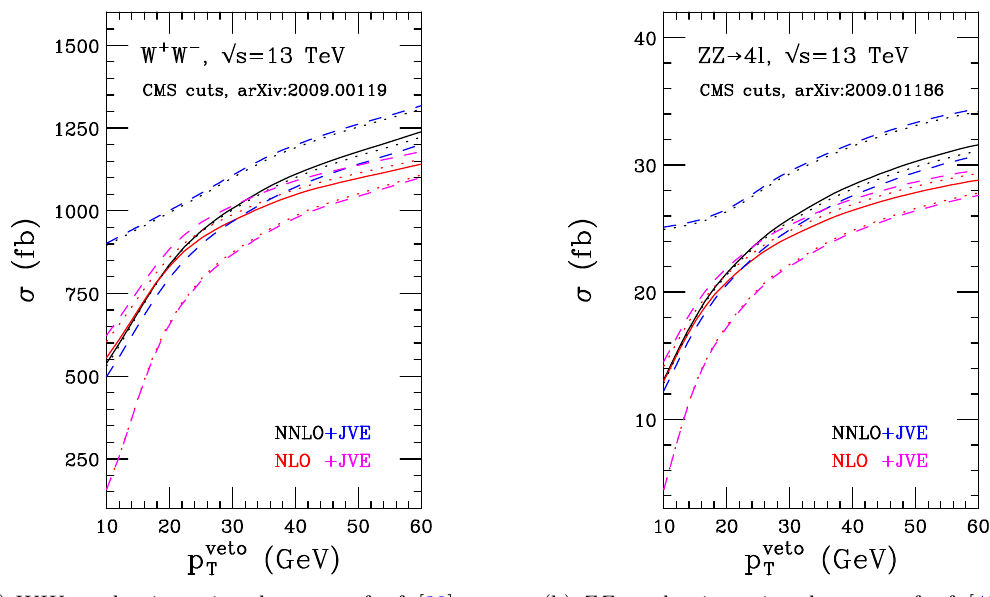
Figure 4 . Comparison of NLO and NNLO fixed order predictions as a function of the jet veto. Central predictions solid, uncertainty estimates using either the two-scale approach (dotted) or the envelope of that and the JVE approach